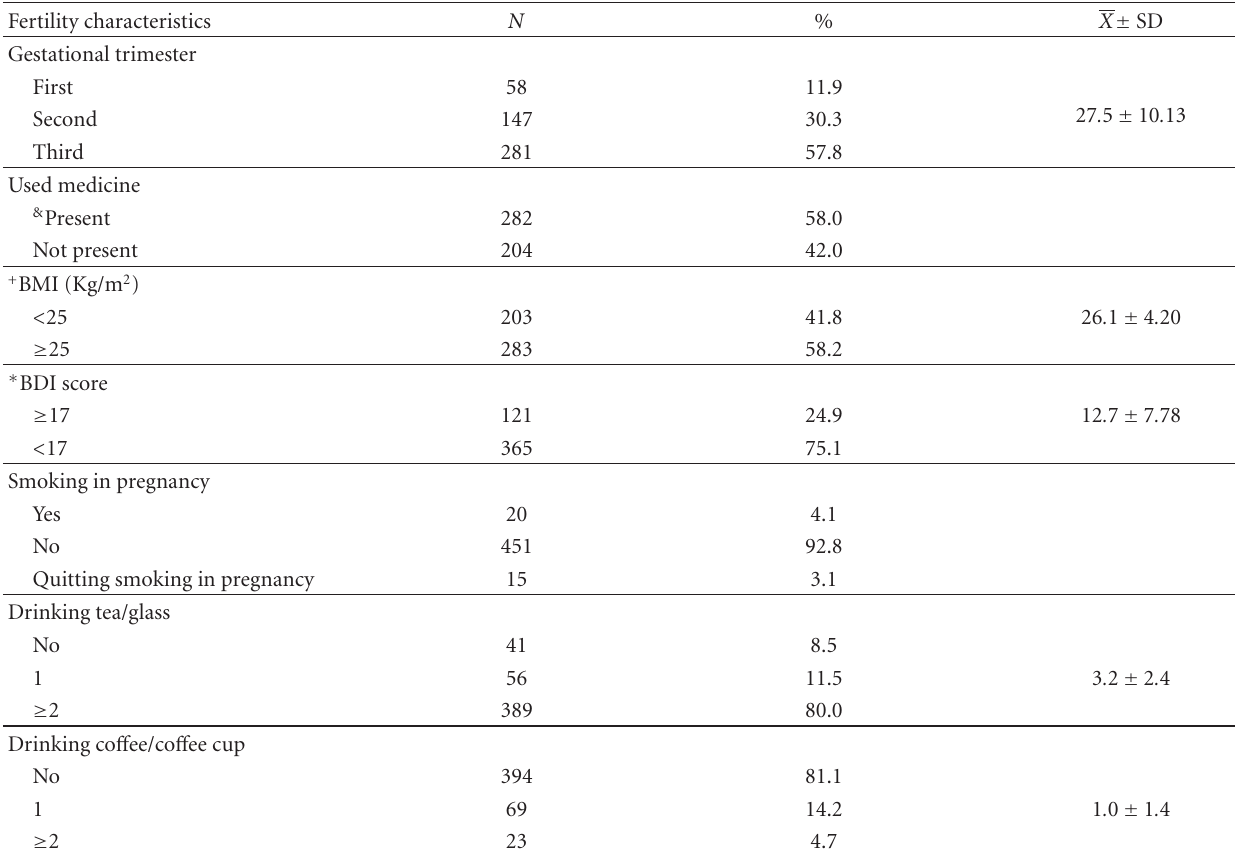
Table 1: Distribution of some of the characteristics of the participants ( N :